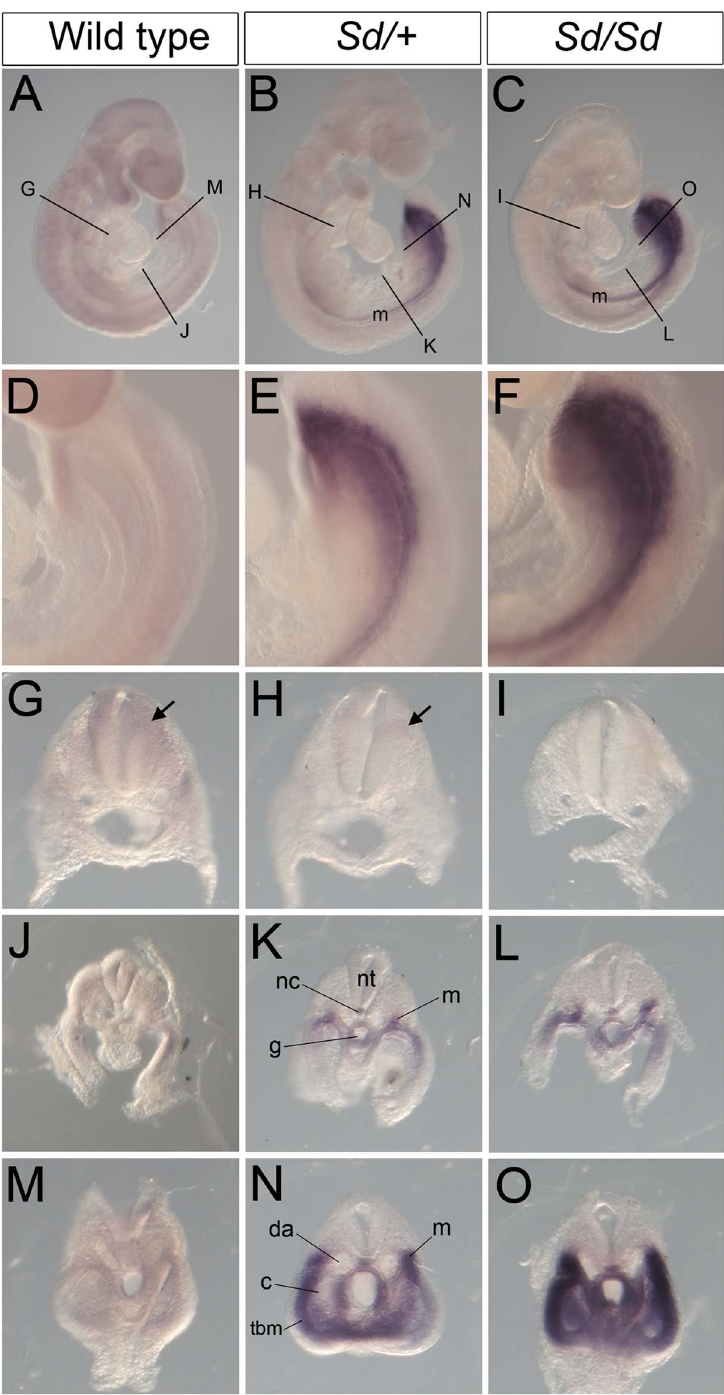
Figure 5. Ectopic expression of Ptf1a in Sd/ + and Sd/Sd embryos at E9.5. (A–C) Whole mount ISH showing Ptf1a expression in wild type, Sd/ + and Sd/Sd embryos at E9.5. Lines indicate corresponding slices in G–O. (D–F) High magnification views of the caudal end of the embryos shown in A,B,C. (G–O) Slices from embryos in A, B and C showing Ptf1a expression at the level of foregut (G–I), midgut (J–L) and the tail bud (M–O) of the embryo. Ptf1a is ectopically expressed in the posterior notochord (nc), mesonephros (m), and tail bud mesenchyme surrounding the gut tube (g) and the coelomic cavity (c) in the Sd/ + and Sd/Sd embryos. da-dorsal aortae, nt-neural tube, tbm-tail bud mesenchyme. Arrows point to expression in the dorsal neural tube. restricting expression to the dorsal spinal cord and maintaining ventral spinal cord [26] and although not specifically reported, are expression in the adult acinar cells (Figure 2B) [25,26]. Reporter also evident in the hindgut at E10.5 (see reference [26], Figure 1B), constructs lacking this enhancer are ectopically expressed in the consistent with the mislocalized expression pattern in Sd/ + and